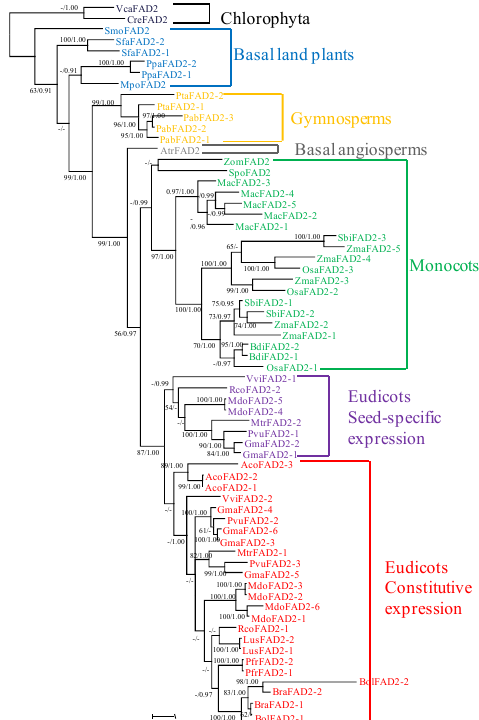
Figure 2. Phylogenetic tree of the FAD2 gene family in plants. The tree was constructed with Maximum Likelihood (ML) and Bayesian methods based on the amino acid (aa) sequences with VcaFAD2 and CreFAD2 as outgroup. Support value (>50% in ML tree) and posterior probabilities (>0.9 in the Bayesian tree) are shown on the respective branches. Gene names and identifiers are shown in Table S1. Different clades are marked in different colors.